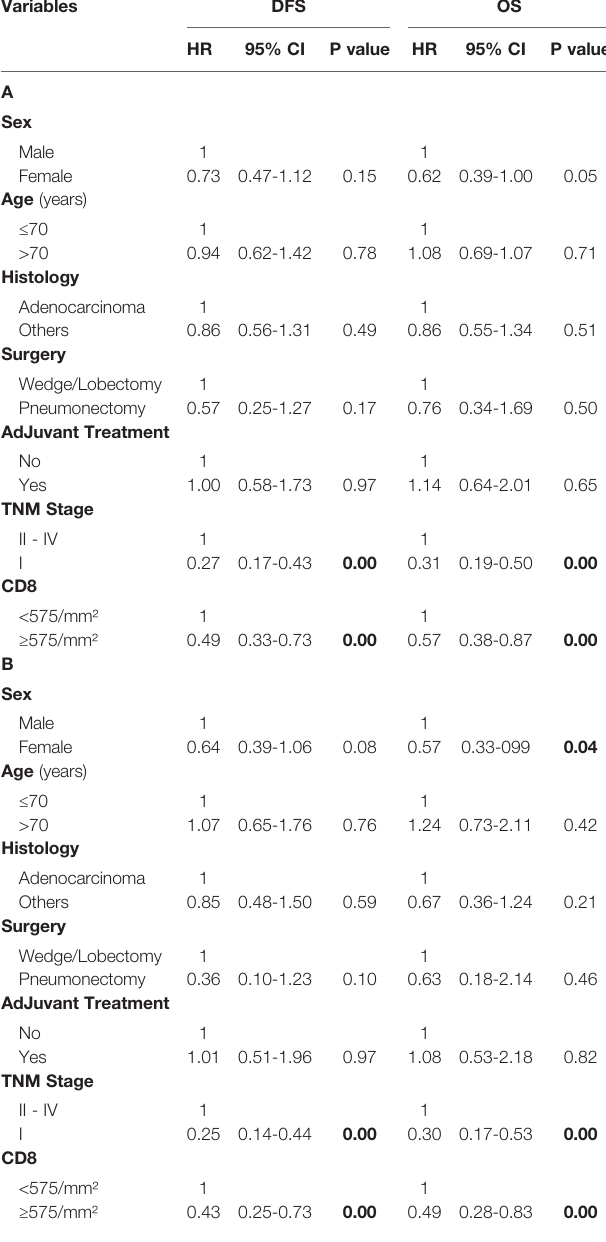
TABLE 2 | Multivariate analysis of predictors of DFS and OS in all NSCLC (A) and in PD-L1 negative NSCLC (B) using the median of CD8 + TILs as the